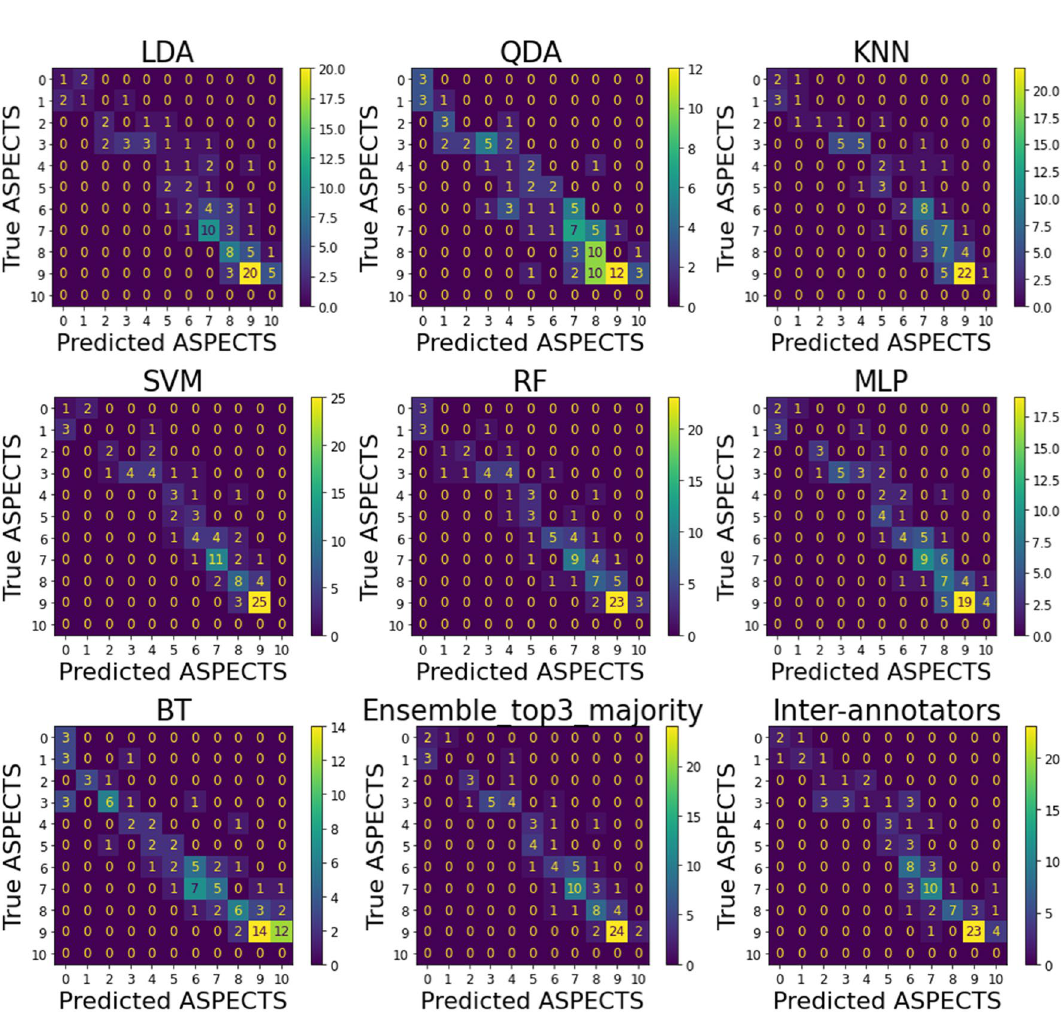
Figure 5. Confusion matrices of ML models in the external testing set (n = 100). A potential perfect model would result in zeros outside the diagonal (i.e., no prediction errors). The cells adjacent to the diagonal represent "acceptable" errors (predicted ASPECTS within ± 1 difference from the ground true